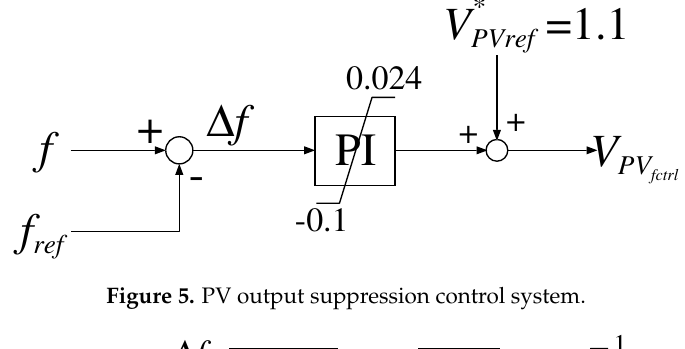
Figure 5. PV output suppression control system.